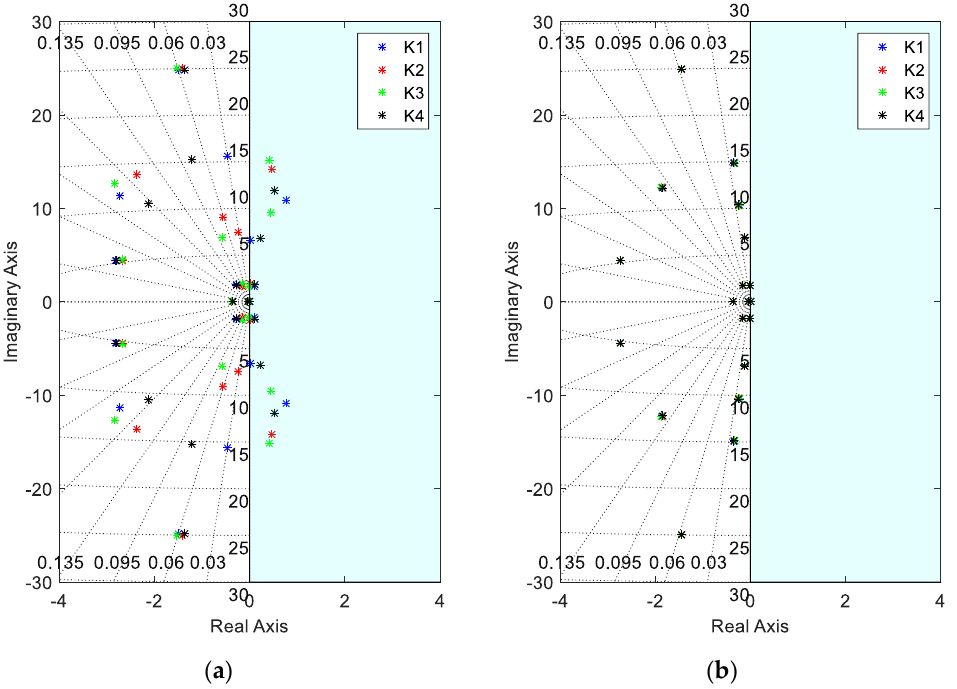
Figure 6. Pole map of the Kharitonov polynomials. 7th order LTI pitch model, ∆𝜷 = 𝟐° and 𝒒 𝟐 .